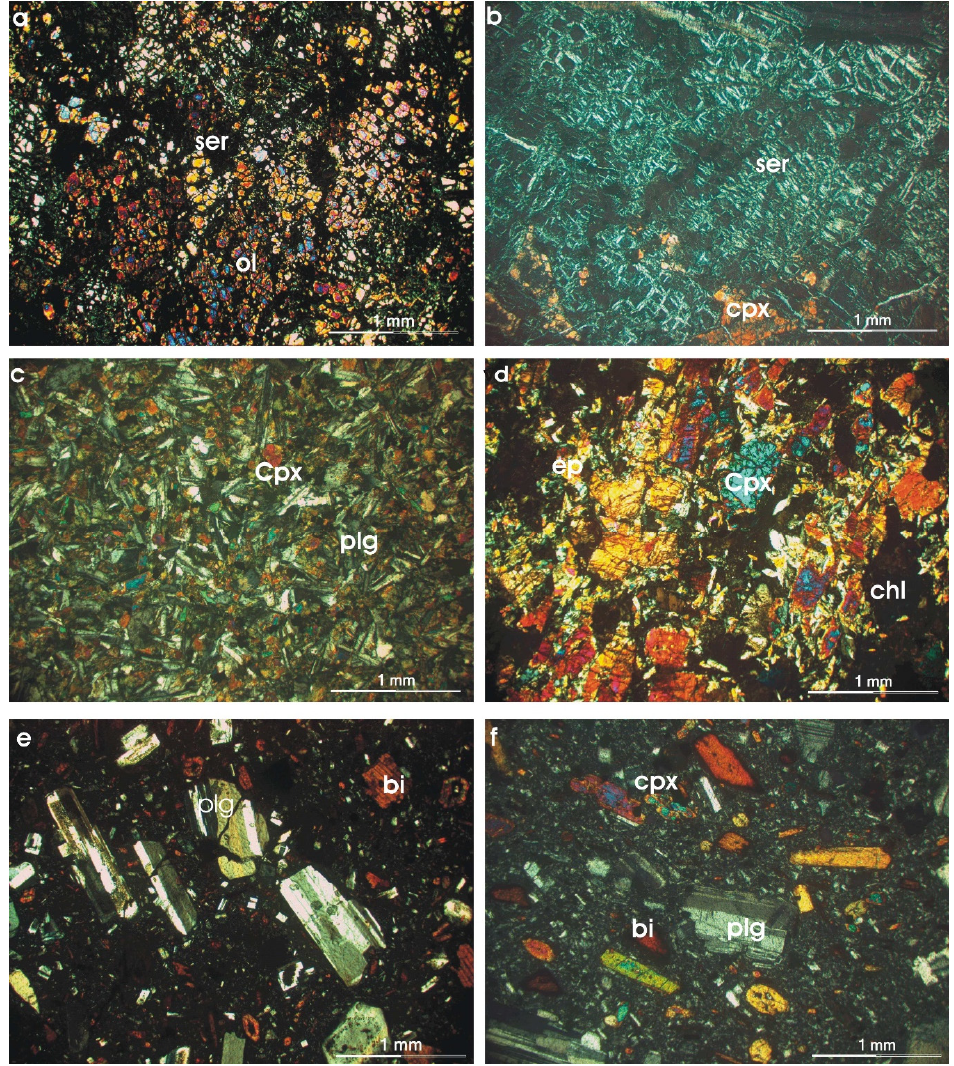
Figure 1. Photomicrographs of representative samples from the investigated rocks showing: ( a